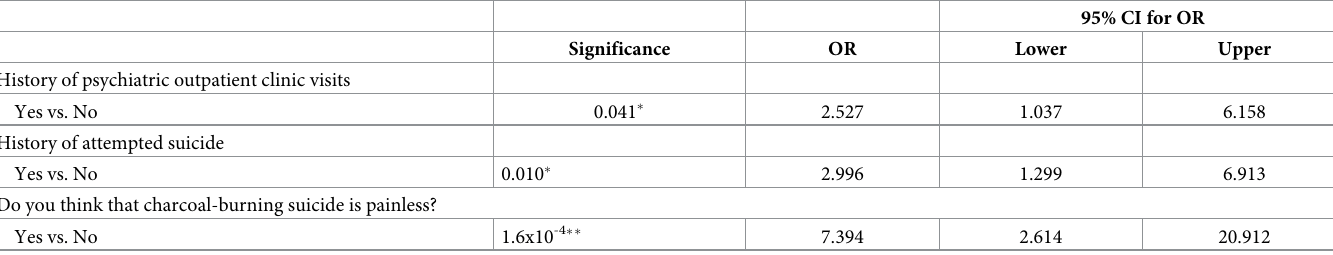
Table 4. Odds ratios and 95% confidence intervals for the risk of having charcoal-burning suicide ideation (N =